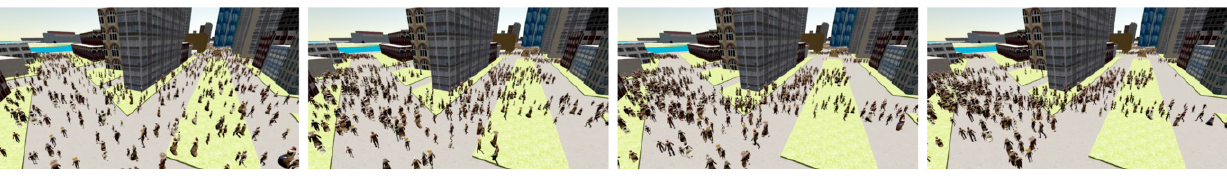
Fig. 14 3D view of the island scenario. Agents split into groups and move to their respective exits. Some agents form queues gradually as they are moving.